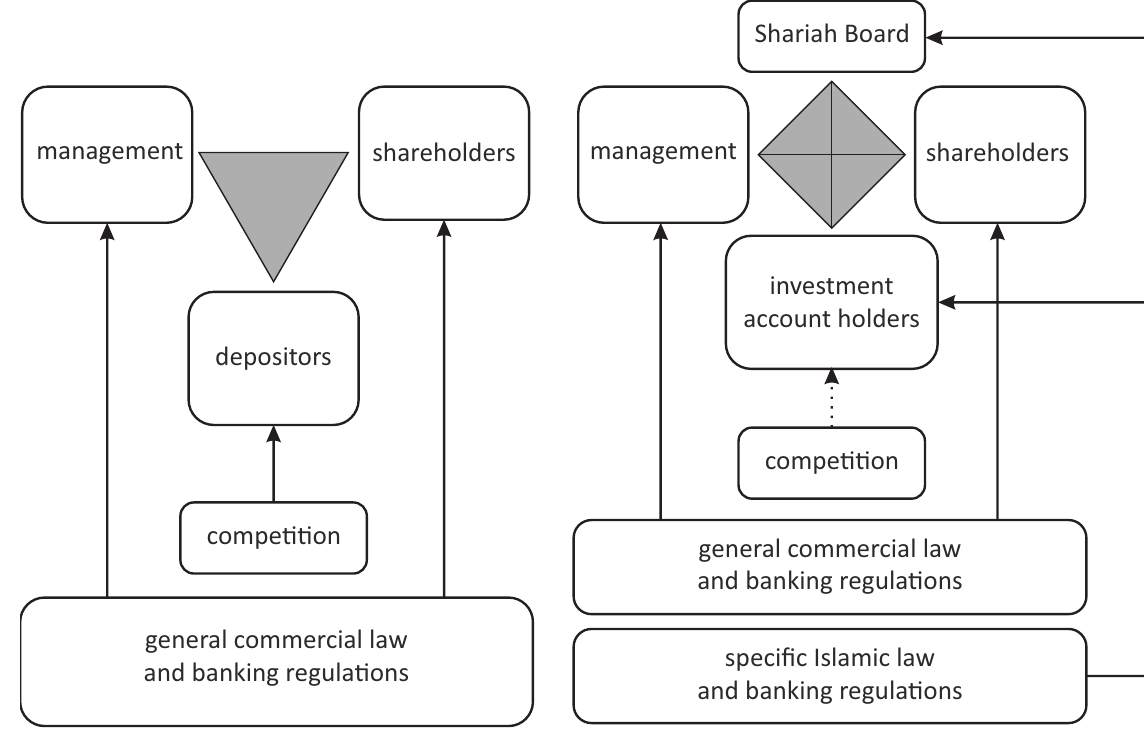
Figure 4. Comparing the governance structure of Islamic and conventional institutions (adapted from Nienhaus,